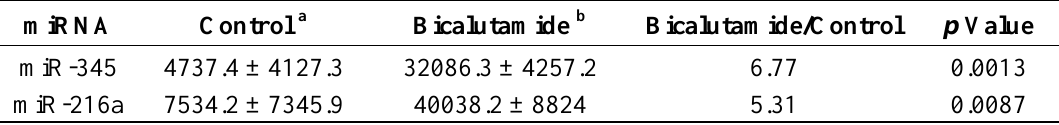
Figure 1. Screening of miRNAs associated with bicalutamide responses in LNCaP cells. ( A ) Schematic representation of screening procedure using a lentiviral miRNA library to identify mediators of the bicalutamide responses in human prostate cancer LNCaP cells. In brief, cells were infected with a lentiviral miRNA library and further cultured in regular media containing normal FBS with or without anti-androgen bicalutamide. Amounts of miRNAs integrated in the genomic DNAs of surviving cells were quantified by microarray; ( B ) Validation of miRNA screening reproducibility using two controls experiment is shown; ( C – E ) Scatter plots of array signal intensities for individual miRNAs for three groups of bicalutamide-treated and vehicle-treated samples (( C ) 10 μM bicalutamide Sample 1 versus Control 1; ( D ) 1 μM bicalutamide Sample 2 versus Control 2; ( E ) 1 μM bicalutamide Sample 3 versus Control 3). Table 1. Retained miRNAs after bicalutamide